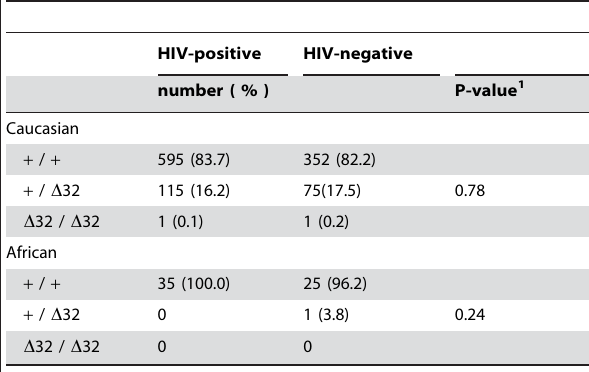
Table 1. CCR5 D 32 genotype distribution in HIV-positive and HIV-negative study subjects